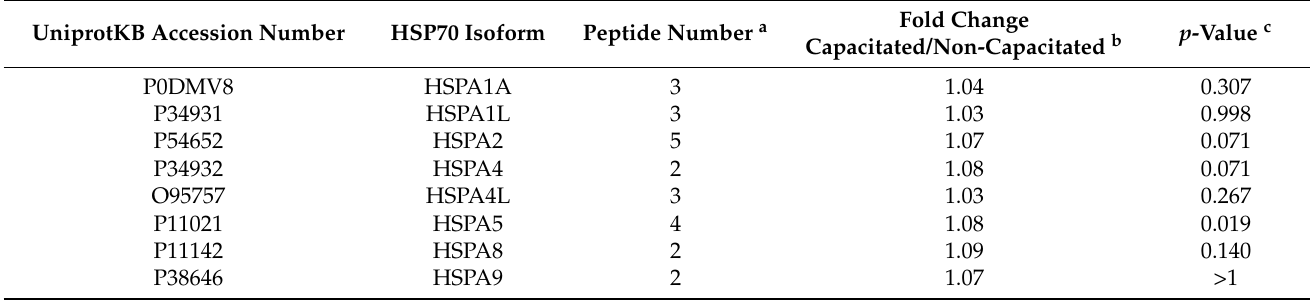
Table 2. Influence of capacitation on the relative abundance of HSP70 isoforms in human